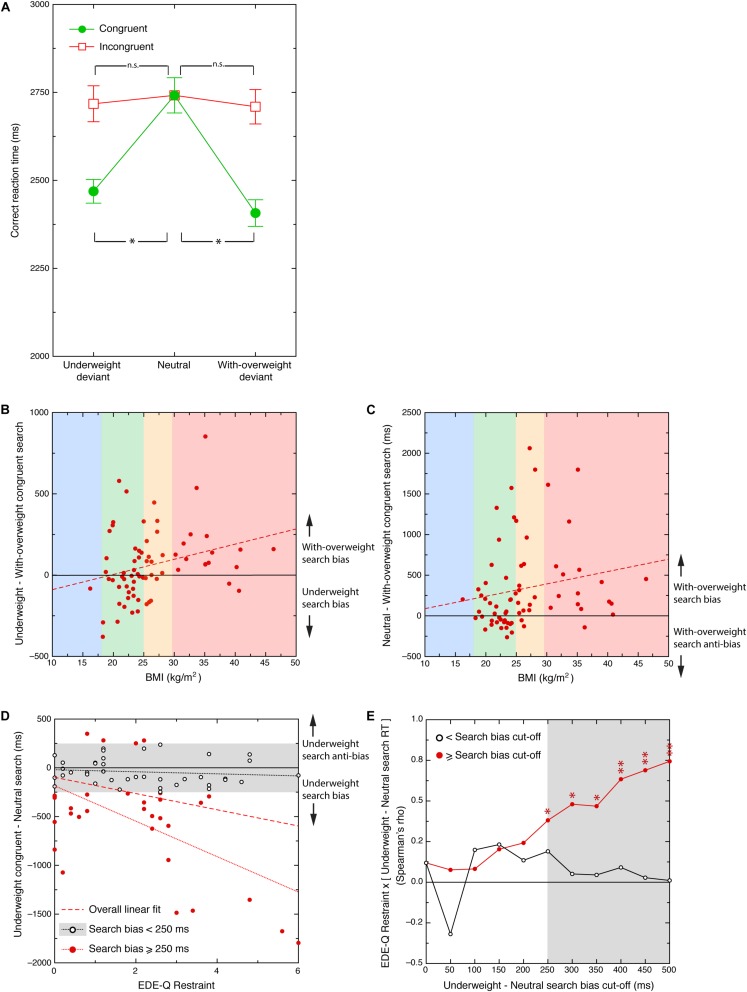
(A) Search times averaged across participants (y-axis) to congruent and incongruent trials (green circles and red squares, respectively) across the three body type conditions. Error bars are between-subject standard errors. Asterisks represent significant differences between both congruent deviant image conditions and the neutral (deviant absent) condition (p < 0.01). (B) Scatterplot showing the relationship between participant BMI and the difference in reaction time to underweight-deviant and with-overweight-deviant bodies on congruent trials. A positive difference score (y-axis) indicates faster search times to with-overweight relative to underweight body images (with-overweight search bias) and a negative difference score faster search to underweight relative to with-overweight body images (underweight search bias). The dashed line is the best fitting linear correlation. Vertically arranged colors represent conventional BMI categories. Unbroken horizontal line indicates zero bias. (C) Scatterplot of the relationship between participant BMI and the difference in reaction time on neutral and with-overweight-deviant congruent trials. Positive difference scores (y-axis) signify faster search times to with-overweight relative to neutral body images (with-overweight search bias). Negative difference scores indicate faster search to neutral relative to with-overweight body images (with-overweight search anti-bias). The dashed line is the best fitting linear correlation. Vertically arranged colors represent conventional BMI categories. Unbroken horizontal line indicates zero bias. (D) Scatterplot showing the relationship between EDE-Q Restraint and the difference in reaction time to underweight-congruent trials and neutral trials. A negative difference score indicates faster search to underweight relative to neutral body images (underweight bias) and a positive score, faster search to neutral relative to underweight body images (underweight anti-bias). Red dashed line is the overall best fitting linear correlation. White circles depict participants who produce weak (< ±250 ms) underweight search bias (within gray region), and red circles, participants with strong underweight search biases (≥ ±250 ms). Black and red dotted lines represent linear correlations between for these weak and strong search biased groups, respectively. Unbroken horizontal line indicates zero bias. (E) EDE-Q Restraint × [underweight – neutral] search time correlations across different levels of underweight-neutral search bias. Red circles/red line show participants with underweight search biases equal to above the variable bias cut-off, white circles/black line show participants with underweight search biases beneath the variable bias cut-off. Asterisks represent statistically significant Spearman’s rho values (∗p < 0.05; ∗∗p < 0.01). Gray region signifies underweight search bias, beyond which significant correlations with EDE-Q Restraint (±250 ms) are observed. Note, the Spearman’s rho value (y-axis) associated with a cut-off score of zero (x-axis) is equivalent to that of the red dashed linear fit in Figure 3D. Unbroken horizontal line indicates zero correlation.